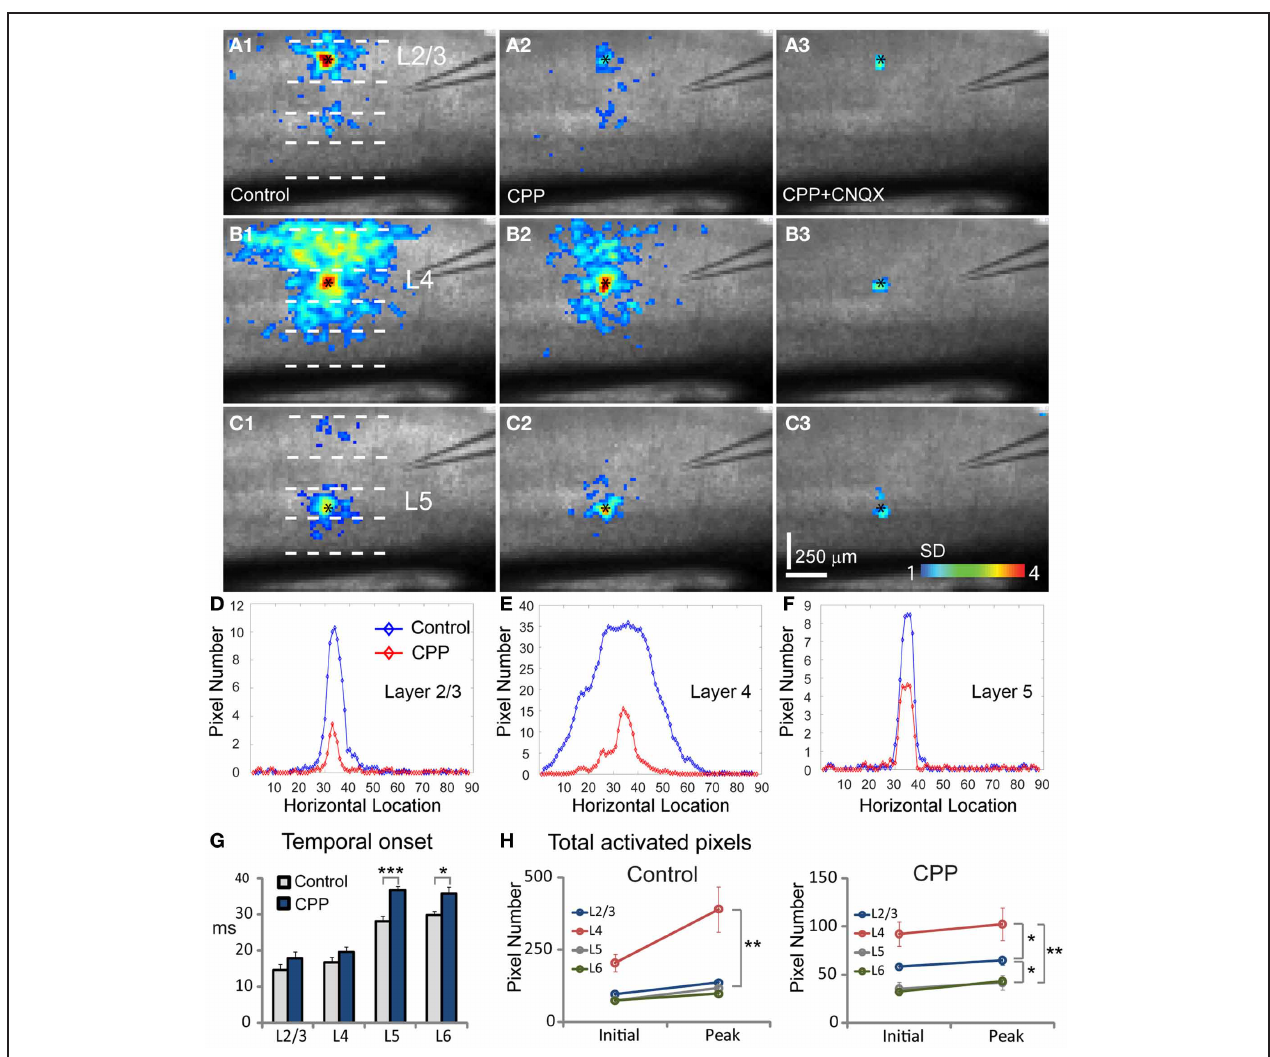
(D , E , and F) Show activation profiles of peak VSD responses under control and CPP conditions for layers 2/3 (A1,A2) , 4 (B1,B2) , and 5 (C1,C2) , respectively. For the plots, the x axis indicates horizontal location of activated pixels from the left to right of the image frame (in the unit of pixel); the y axis denotes the average number of column-wise summed activated pixels across image frames at the peak response phase. (G) Plots temporal onsets of VSD responses in control and CPP conditions. (H) Shows the size of VSD responses quantified by the average number of activated pixels across 10 frames in the initiation phase and across 10 frames in the peak phase, for both control and CPP treated slices. Data are presented as mean ± SE. ∗ P < 0 . 05. ∗∗ P < 0 . 01. ∗∗∗ P < 0 .